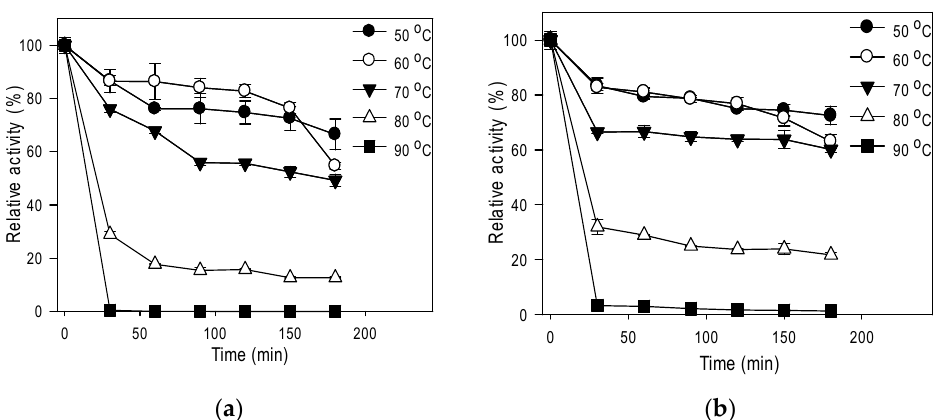
Figure 3. Effect of temperature on stability. ( a ) R5-SazCA; ( b ) R5-SazCA-SP. The activities before incubation were set as 100%. Aliquot of enzyme solution was assayed for its residual CO 2 hydratase activity every 30 min.